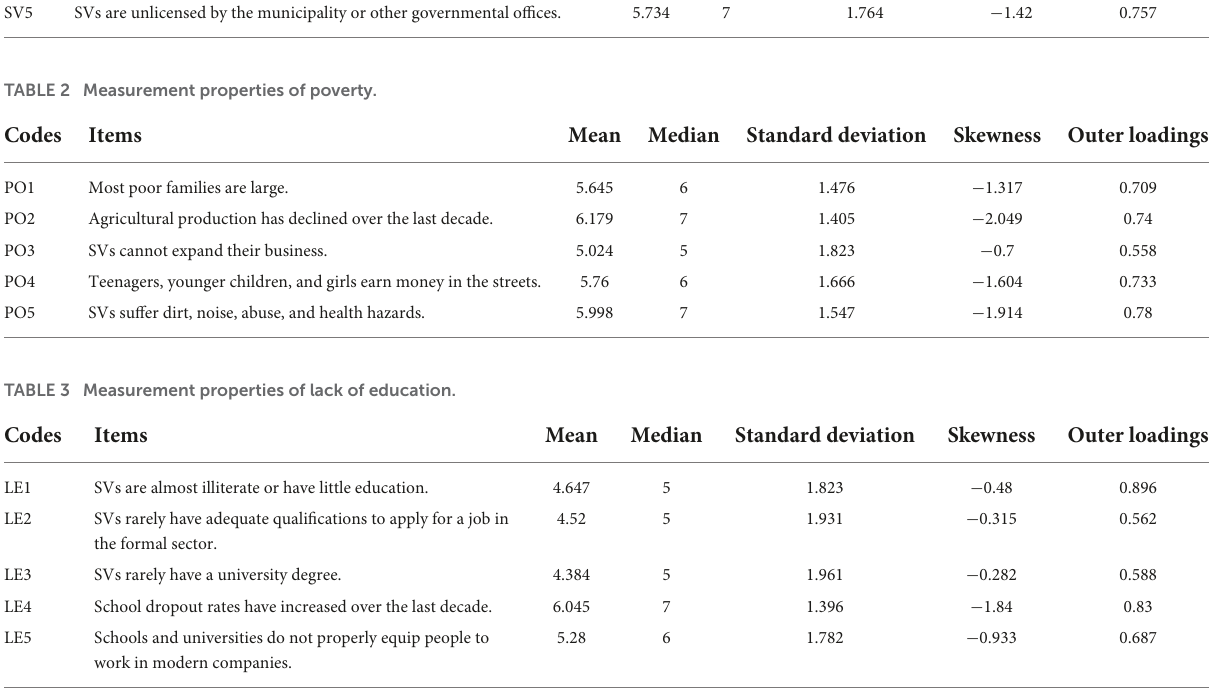
TABLE 4 Measurement properties of immigration.